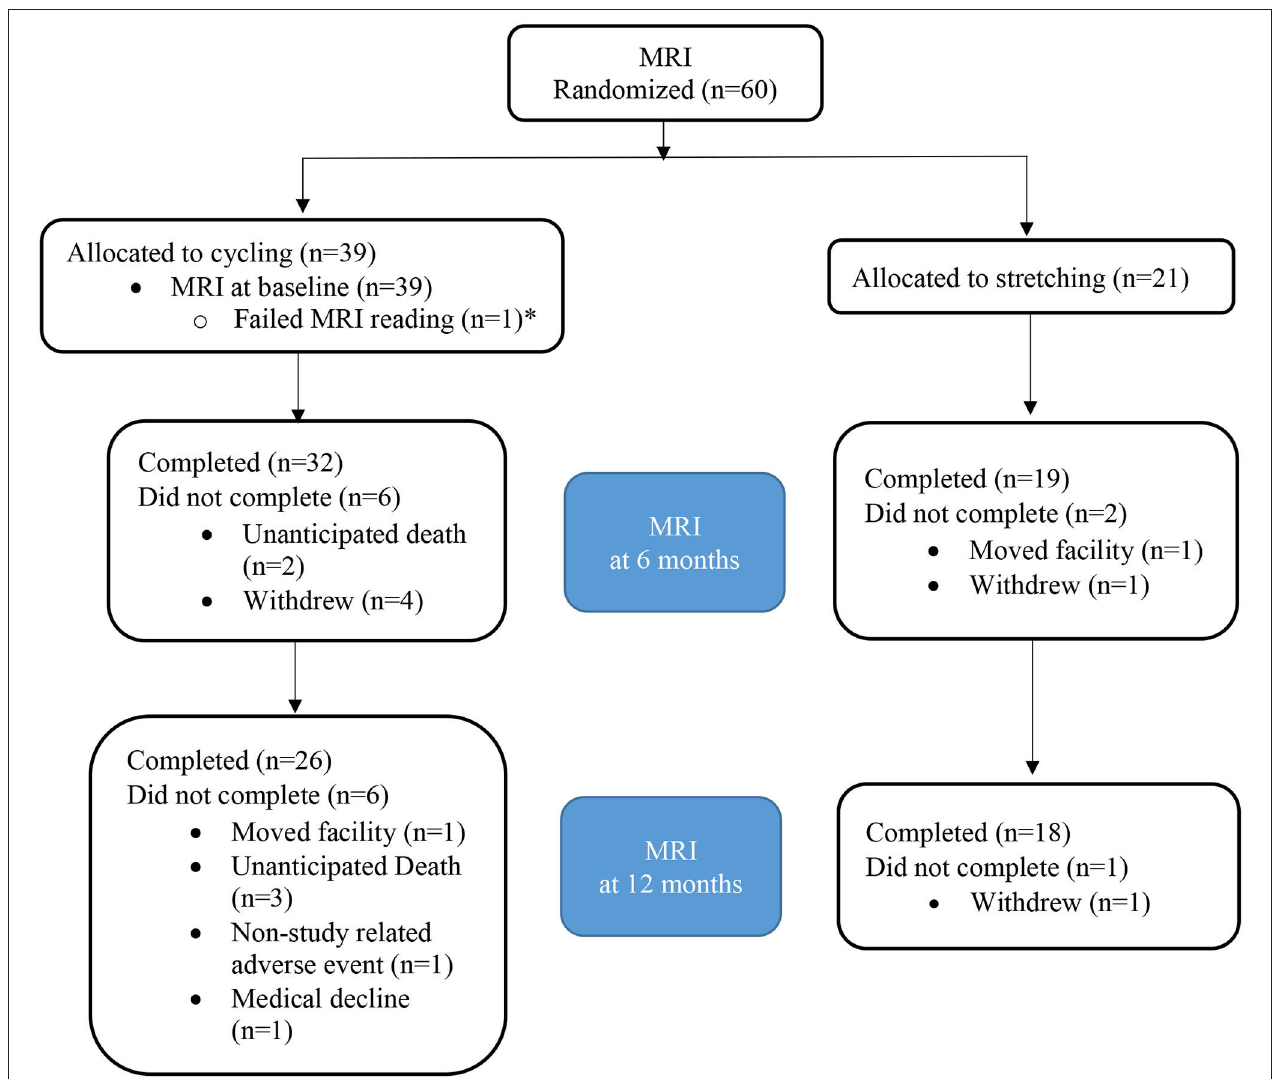
FIGURE 1 | CONSORT diagram for MRI. *Patient with failed MRI at baseline excluded as comparison to baseline not